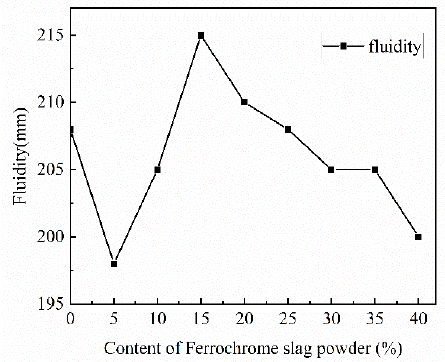
Figure 7. Flow chart of cement mortar.